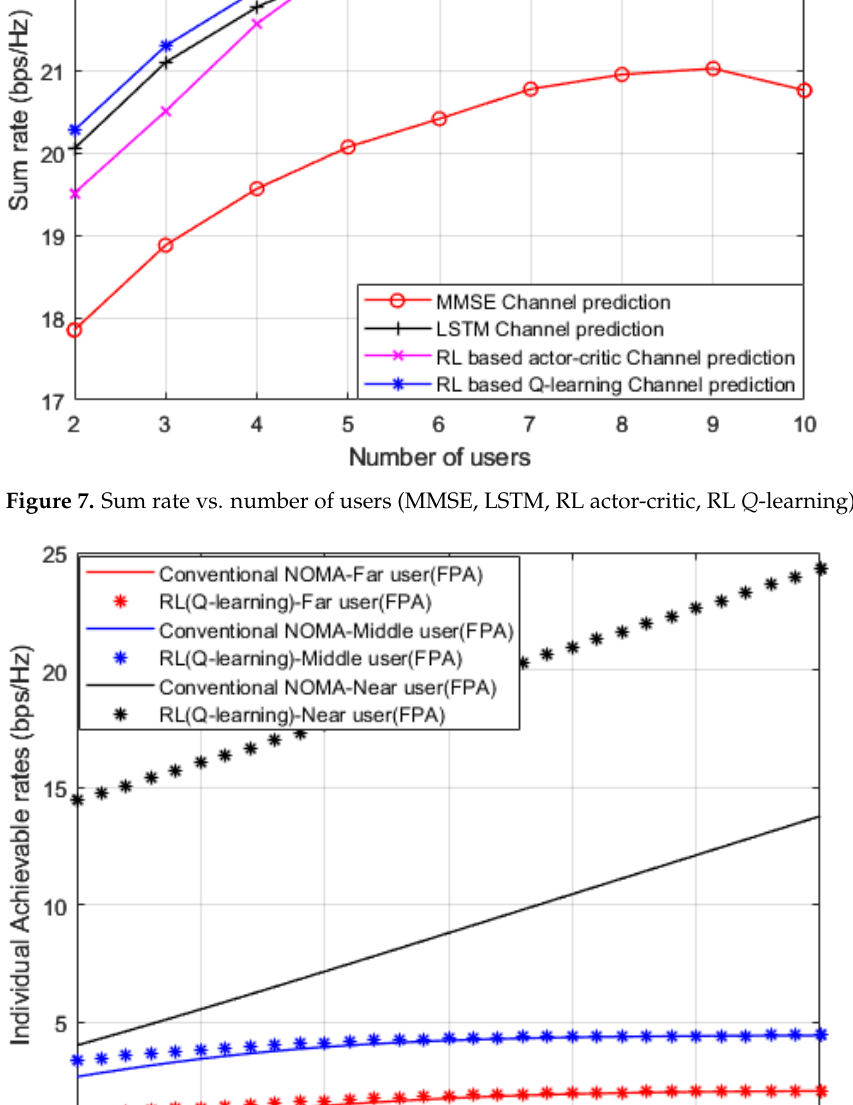
Figure 8. Individual rate vs. power ( Q ‐ learning, Conventional NOMA (MMSE)).